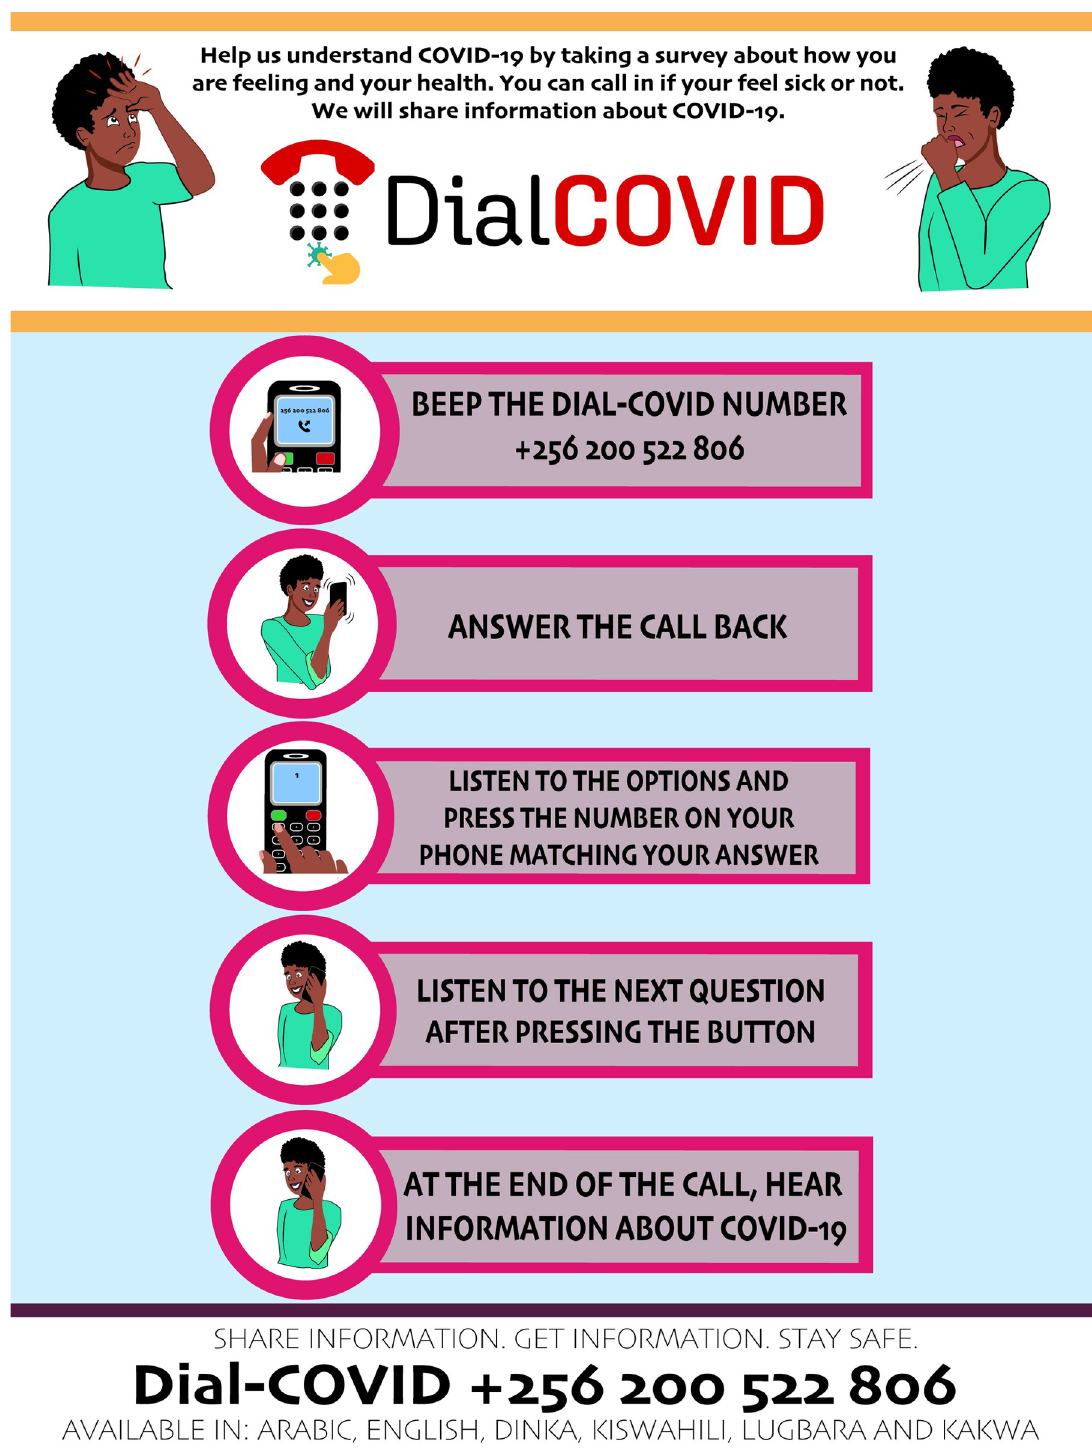
Fig 2. Dial-COVID poster advertisement